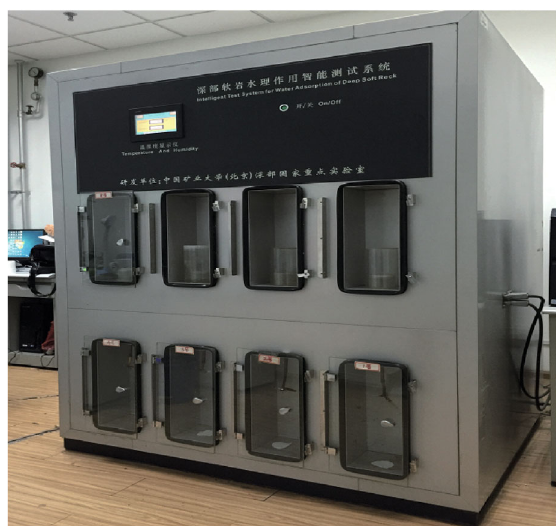
Figure 7: Intelligent test system for water absorption of soft rock.